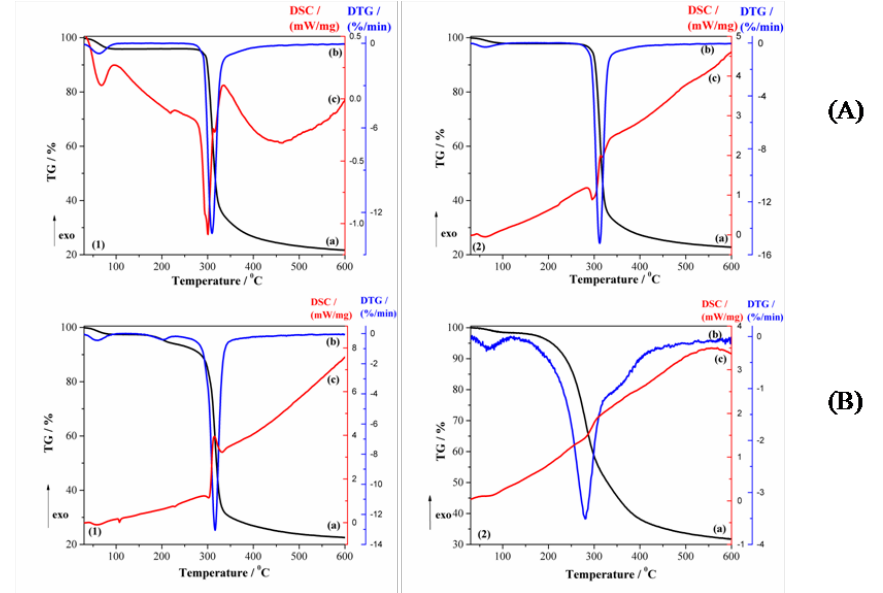
Figure 7. Thermal curves (TG, DTG and DSC) in ( A1 ) β -CD ( a ) TG, ( b ) DTG and ( c ) DSC and ( A2 ) processed β -CD (a) TG, (b) DTG and (c) DSC (dynamic argon atmosphere, β = 5 °C min −1 ) and ( B1 ) the CAP- β -CD physical mixture (a) TG, (b) DTG and (c) DSC and ( B2 ) the CAP- β -CD inclusion complex (a) TG, (b) DTG and (c) DSC (dynamic argon atmosphere, β = 5 °C min −1 ).